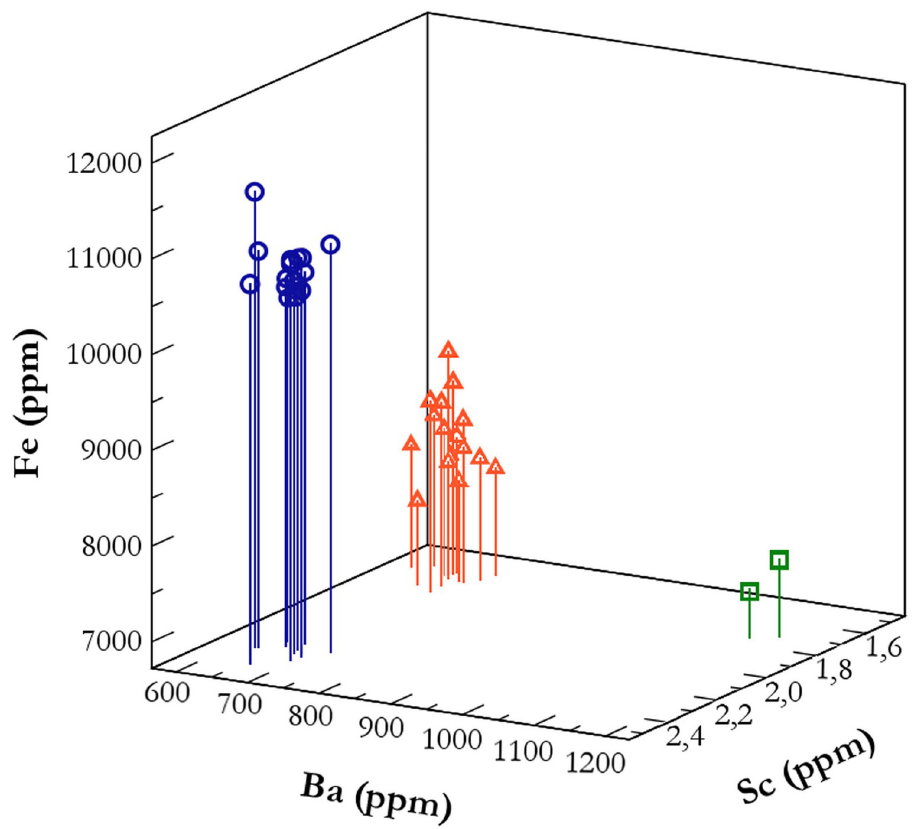
Fig 7. Ternary Fe-Cs-Sc diagram for the 36 Quartier Nu artifacts analyzed using NAA. Le Bourdonnec, F.-X; original copyright with the authors.